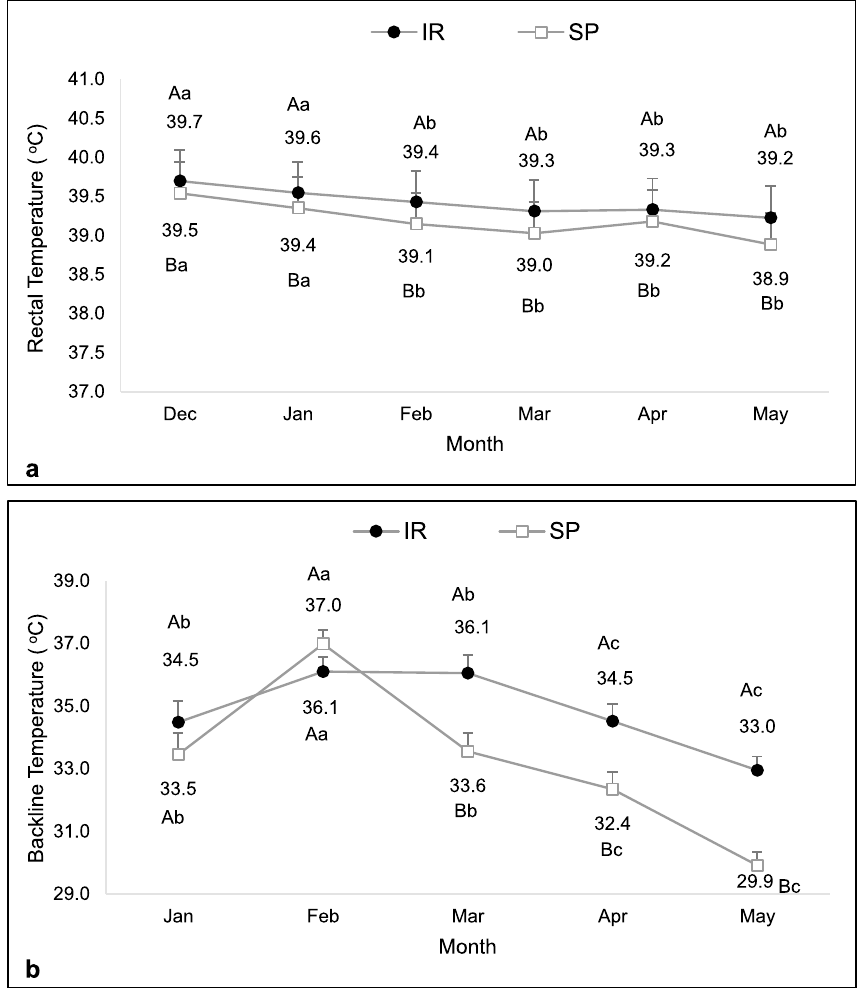
Figure 3. Rectal ( a ) and back line ( b ) temperatures of heifers kept in the silvopastoral (SP) or intensive rotational (IR) grazing systems. For rectal temperature, main effects were observed. For backline temperature, an interaction between system and month was observed. A,B Different capital letters indicate a significant difference between systems. a,b,c Different lowercase letters indicate a significant difference between